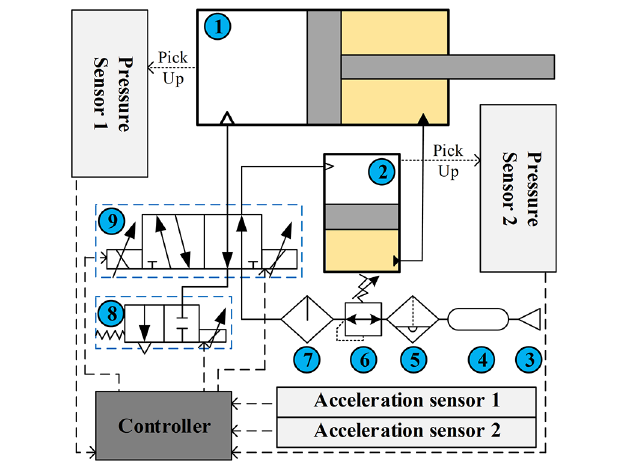
Fig. 2. Principle diagram of gas – liquid active guide